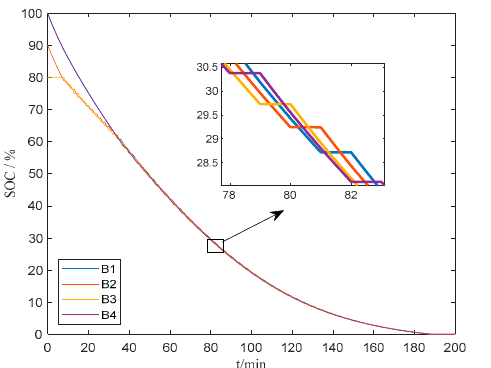
Figure 6. Control circuit of algorithm.